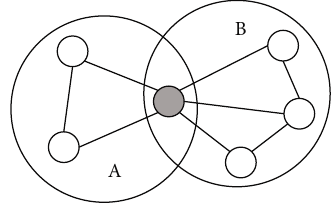
Figure 2: An example of overlapping community